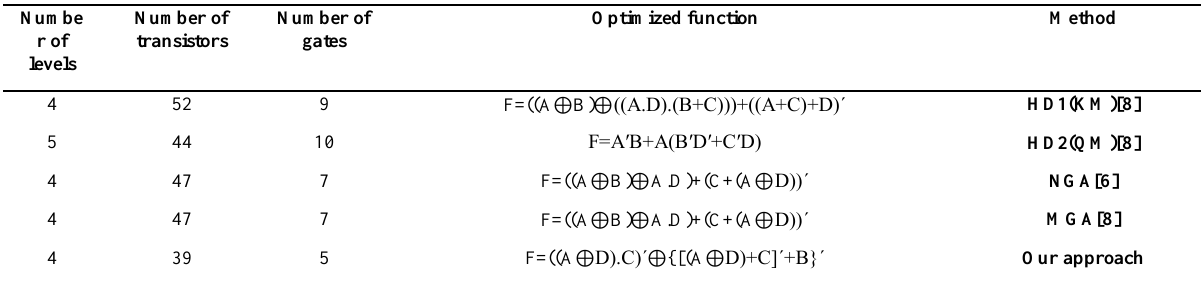
Figure 9. Convergence diagram for F Figure 8. Circuit for F 3. Table 4. Comparison of proposed method vs . similar approaches in terms of general design parameters for function F 3 .